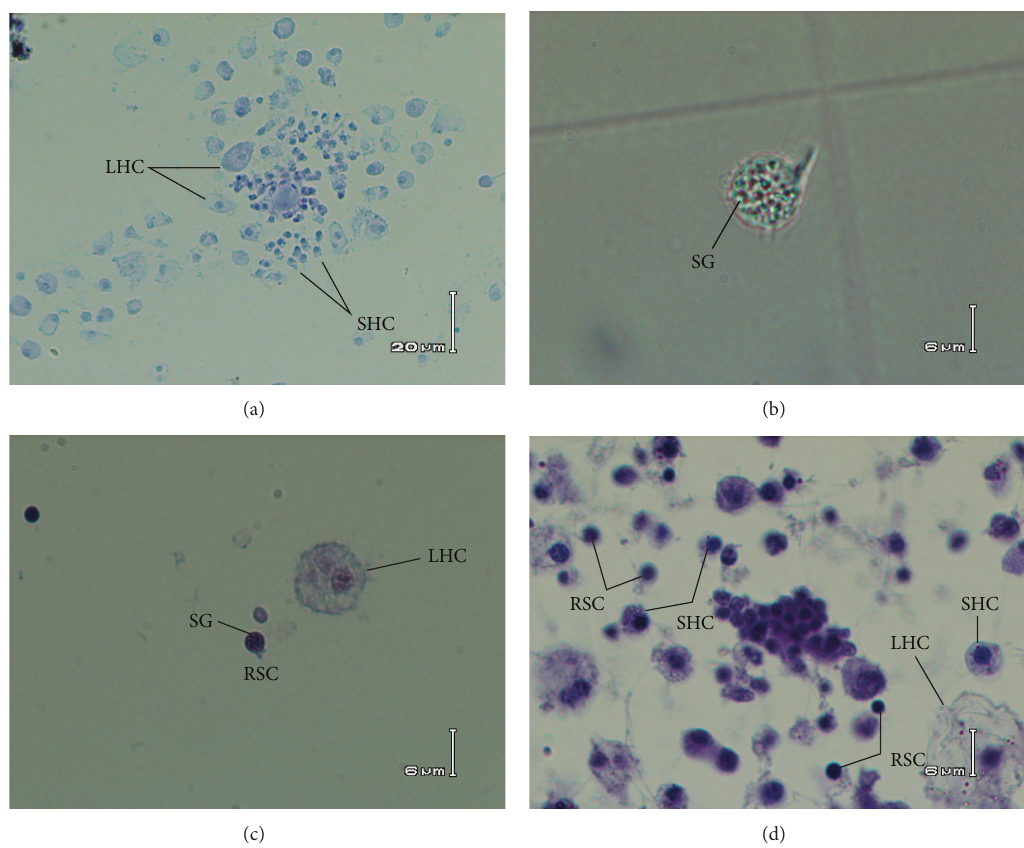
Figure 4: Circulating cells of Acanthaster planci 2 hours after injection. Light microscopy: (a) small hyaline cells (SHC) and large hyaline cells (LHC), Gram stain; (b) colourless spherule cell (CSC) including secretory granules (SG), fresh sample; (c) red spherule cell (RSC) with SG inclusion and SHC, Gram stain; (d) all four types of cells observed together, Gram